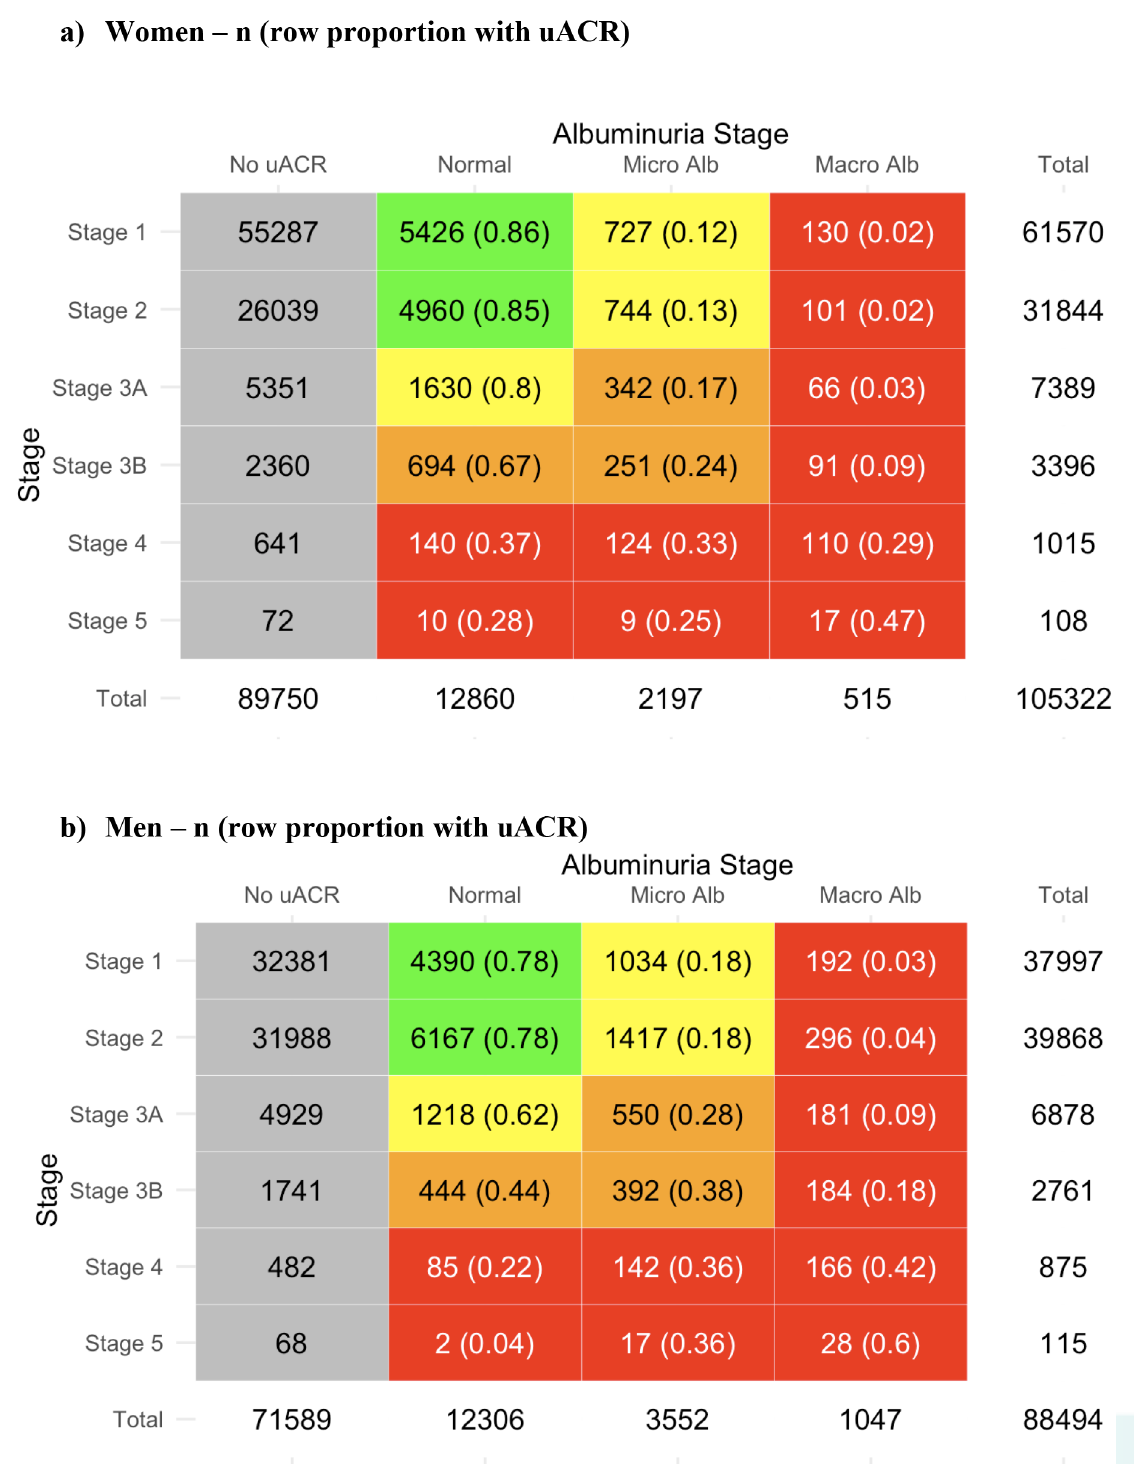
Figure 5: KDOQI prevalence [11] of CKD in Women and Men using first eGFR and uACR measurement in the 2017